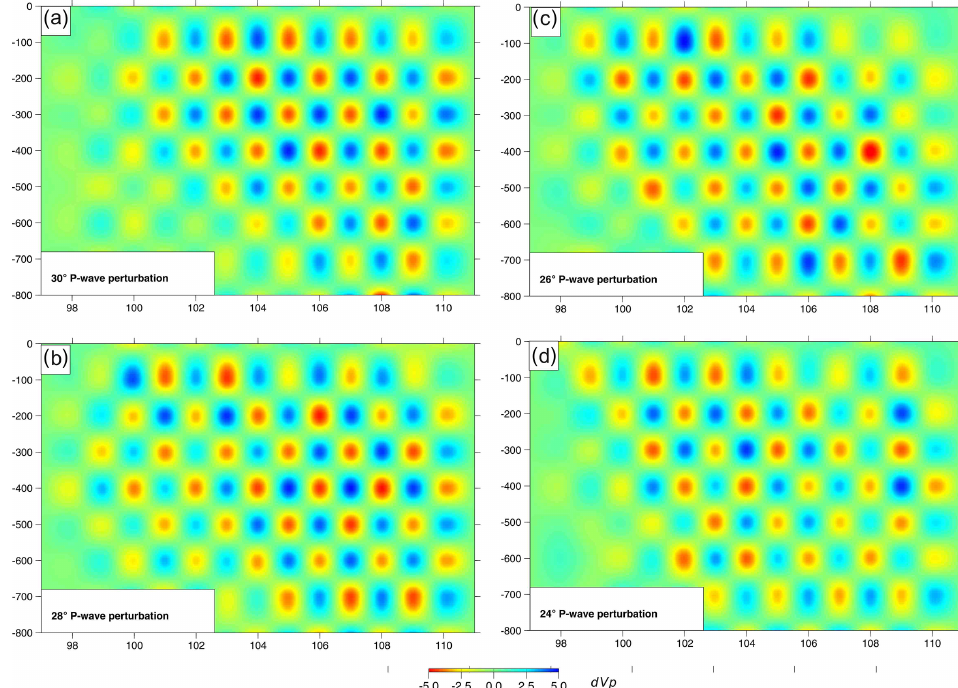
Figure 6. Checkerboard resolution test along the west–east profiles ( a , b , c , and d are at latitudes 24, 26, 28, and 30 ◦ N, respectively) (see Fig. 1 for profile location).